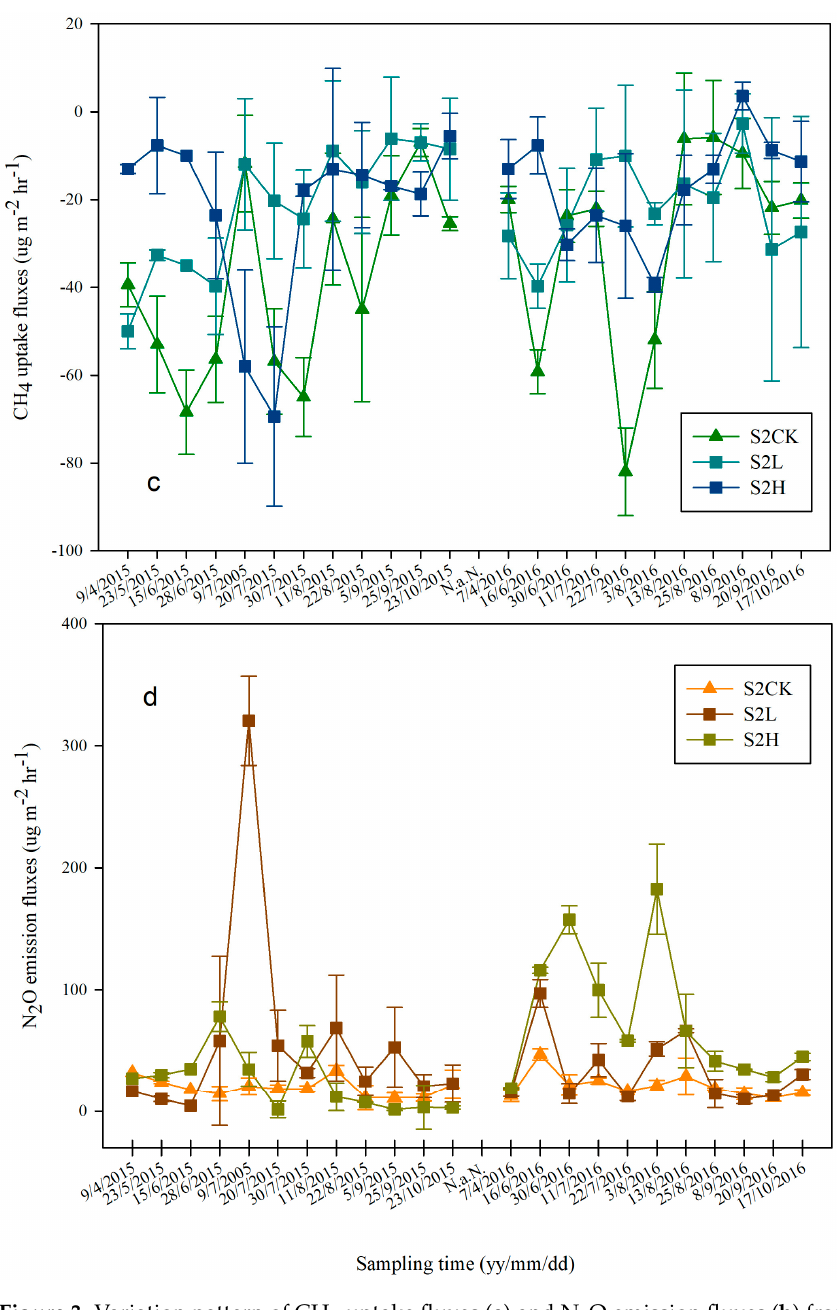
Figure 3. Variation pattern of CH 4 uptake fluxes ( a ) and N 2 O emission fluxes ( b ) from S 1 , and CH 4 uptake fluxes ( c ) and N 2 O emission fluxes ( d ) from S 2 with three levels of nitrogen fertilization (H, L, and CK) in saline soil from 2015 to 2016. Vertical bars indicate the mean and standard error. (S 1 : slightly saline soil; S 2 : strongly saline soil).